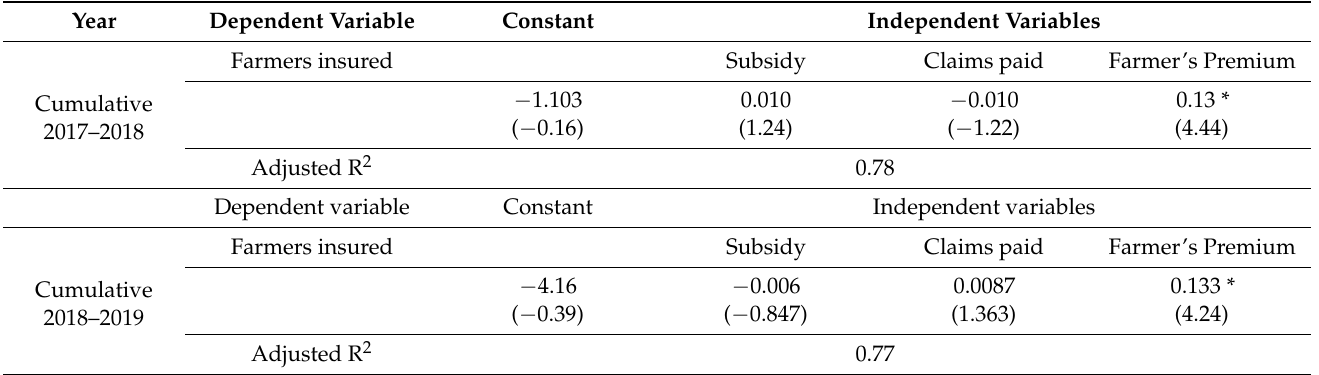
Table 9. Effects of insurance characteristics on farmers covered under